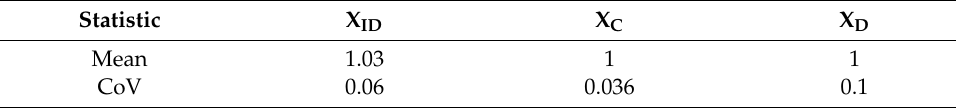
Table 4. Statistics for reduction factor’s bias